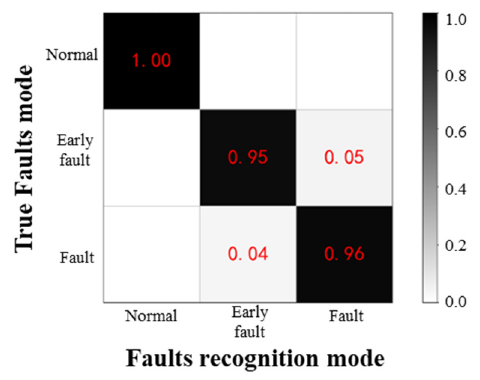
Figure 13. Confusion matrix for fault diagnosis.